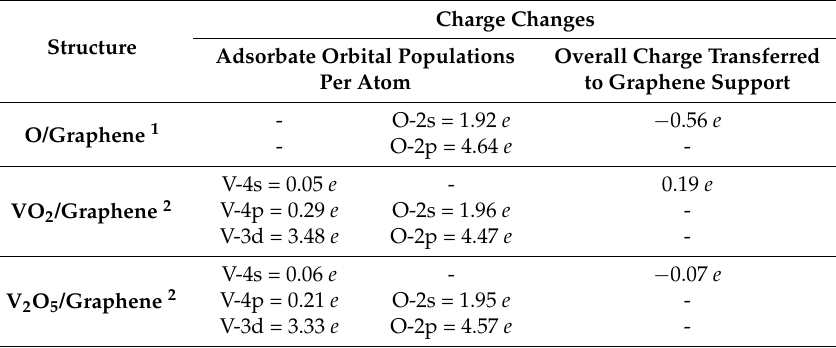
Figure 9. Density functional theory (DFT) calculations. Total electronic density of state (DOS) spectra per atom eV for ( a ) clean graphene, VO 2 /graphene, V 2 O 5 /graphene (4 × 4 graphene supercell); partial DOS spectra of ( b ) VO 2 /graphene and ( c ) V 2 O 5 / graphene for V d, O 2s and O 2p orbitals and spd graphene. Schematics of graphene, vanadium oxide and vanadium pentoxide clusters on the 4 × 4 graphene supercell (top view, right panel). The vertical line is the Fermi level. Table 4. Charge changes (or transfer) between adsorbates (adatoms) and graphene monolayer support relative to free atoms and clean graphene.